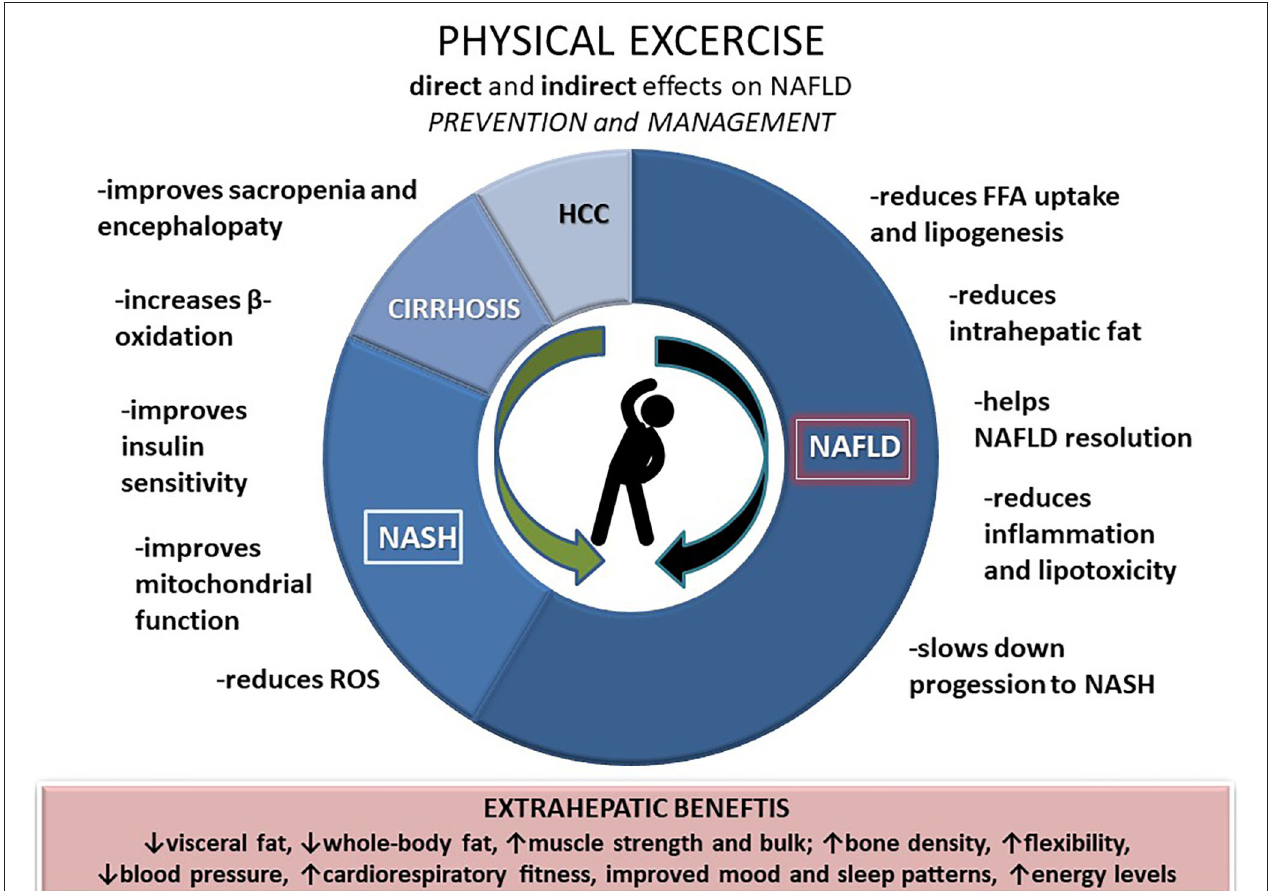
FIGURE 1 | Direct and indirect effects of physical exercise on